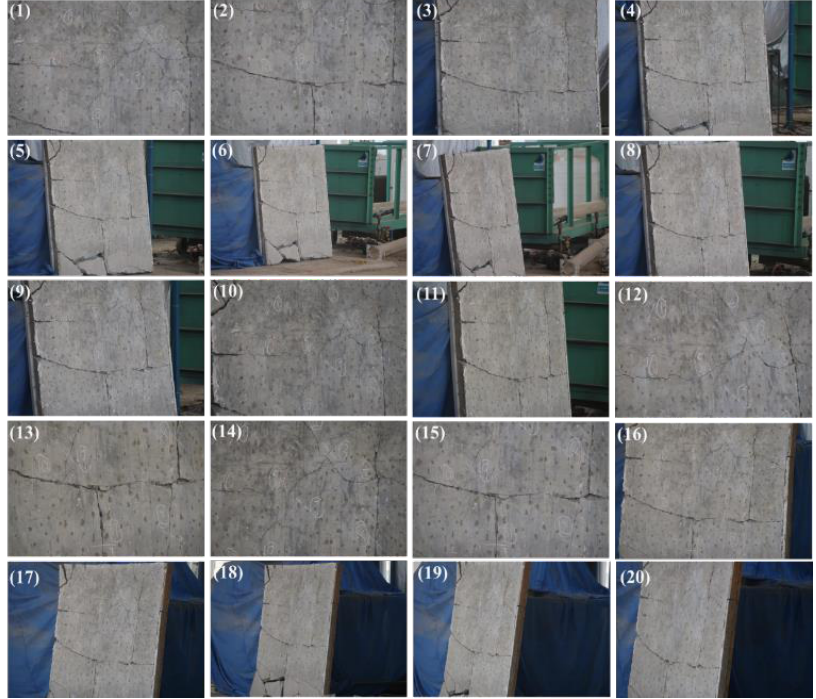
Figure 20. Images of concrete wall photographed from different positions. The distances and